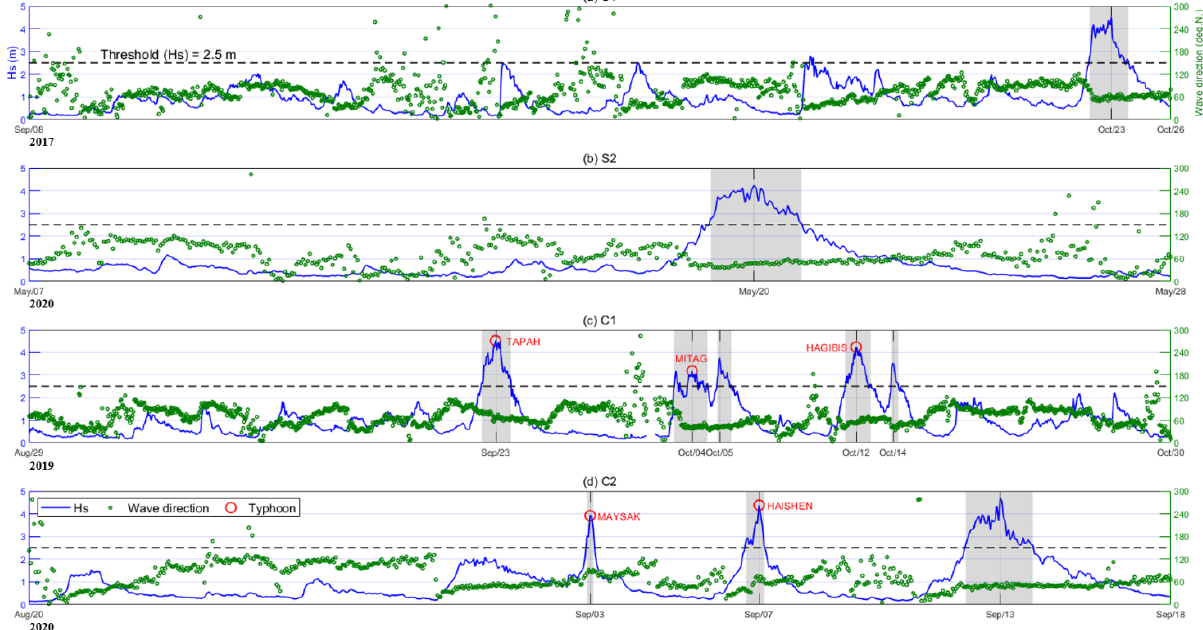
Figure 2. Time series of significant wave height (solid blue line) and wave direction (green circle) collected between pre- and post-storm bathymetry for each storm condition (S1 ( a ); S2 ( b ); C1 ( c ); and C2 ( d )). The red circles indicate when typhoons affect the study area (Maengbang beach).